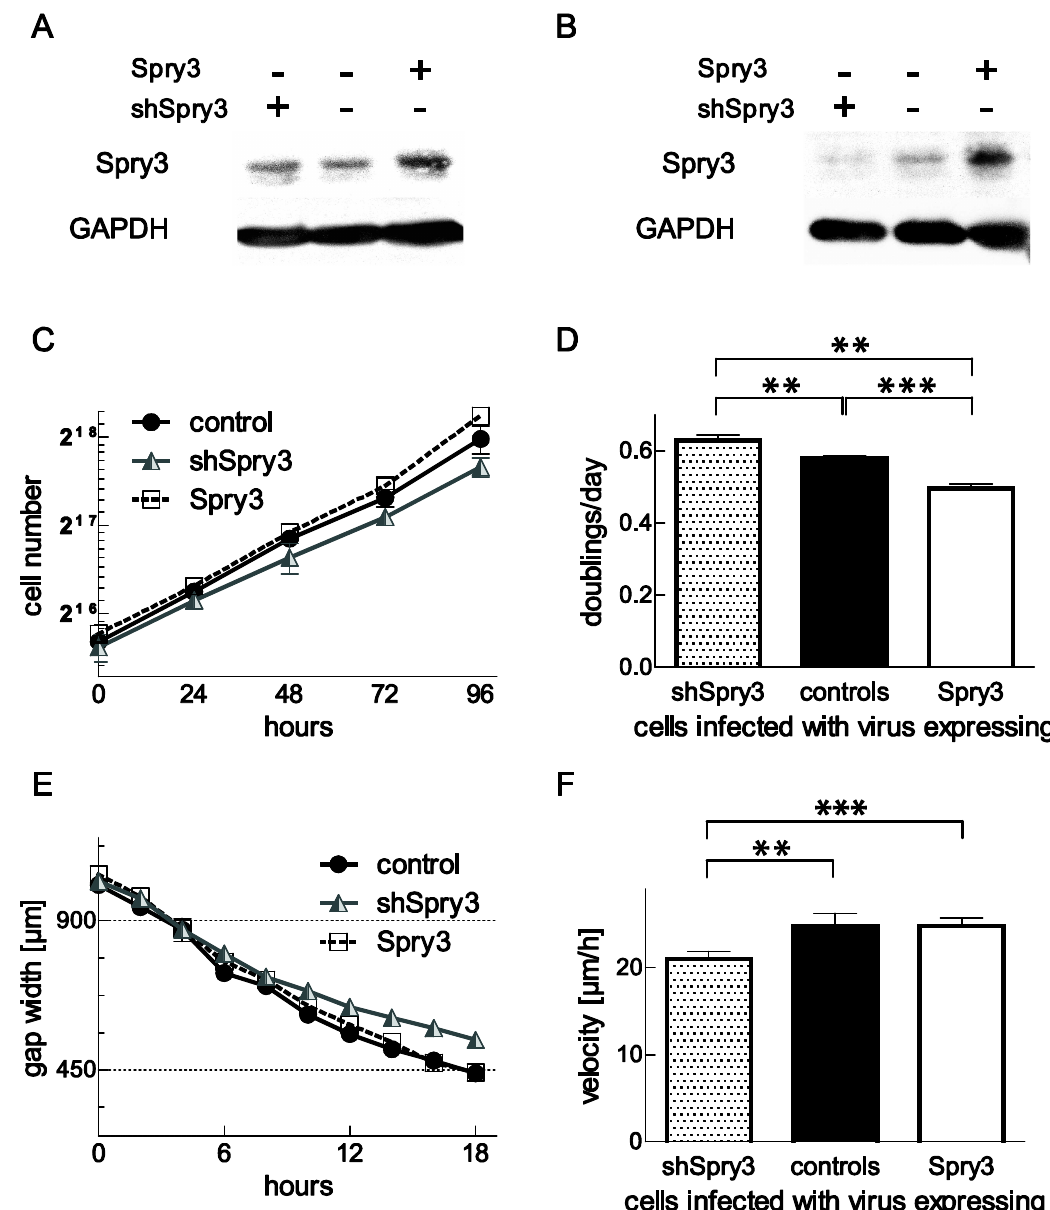
Figure 6. Verification of Spry3 impact on cell proliferation and migration by downregulation of the endogenous protein levels. DBTRG-05MG ( A ) and U373 ( B ) cells infected with adenoviruses expressing Spry3, shSpry3 or a control protein were analyzed concerning their Spry3 protein levels. ( C ) Three days after infection with the indicated viruses a growth curve analysis was performed in U373. ( D ) The doubling time of three experiments was calculated by performing an exponential growth equation and the mean doublings per day ± SEM are depicted. ( E ) U373 cell expressing the indicated proteins were cultured to form a close layer before a scratch assay was performed. Measurements of three replicative gaps were performed every two hours and a representative experiment is shown. ( F ) Velocities of three experiments were calculated using linear regression in GraphPad Prism and a summary is